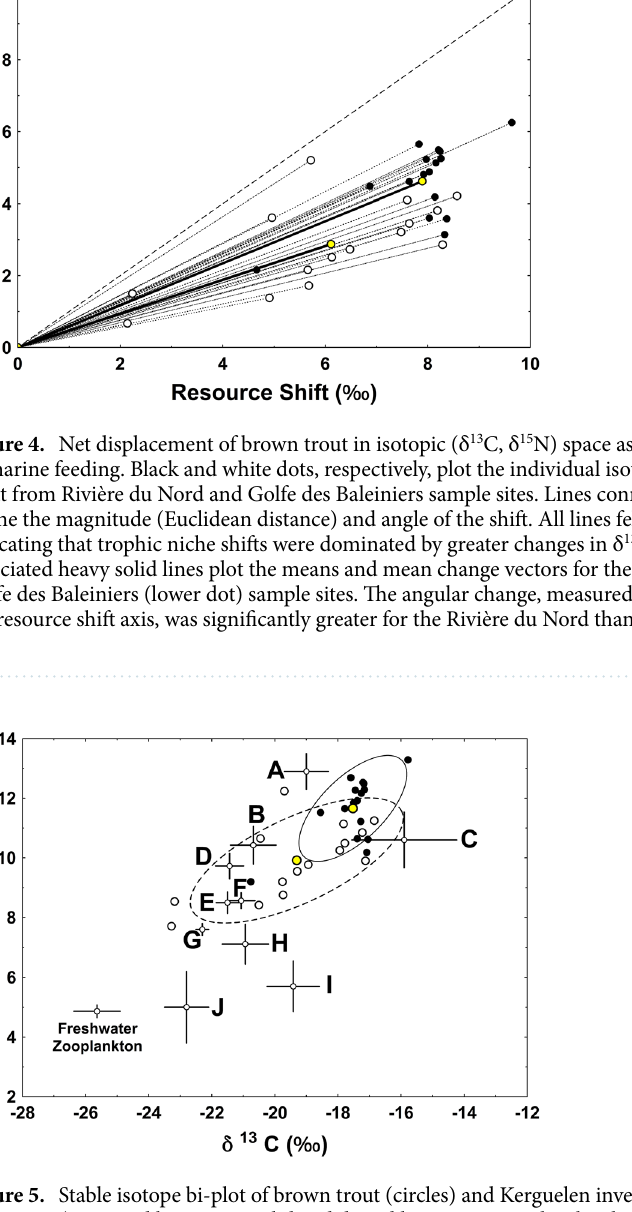
Figure 5. Stable isotope bi-plot of brown trout (circles) and Kerguelen invertebrate and fishes (black squares and crosses) grouped by Genus. Solid and dotted lines, respectively, plot the standard ellipse area (SEA C ) for Rivière du Nord (black circles) and Golfe des Baleiniers (open circles) sampled brown trout. Ellipse means are denoted by the yellow circles. Freshwater zooplankton are labelled and provided as a freshwater reference value. Species plotted (and data sources) include: A— Dissostichus eleginoides (Cherel et al. 63 ); B— Cephalopod sp. (Cherel et al. 63 ; Guerreiro et al. 64 ); C— Ecinoderms (Saucede et al. 60 ) ; D— Gymnoscopelus sp. (Cherel et al. 92 ); E— Protomyctophum sp. (Cherel et al. 92 ); F— Electrona sp. (Cherel et al. 63 ; Cherel et al. 92 ); G—